Question: Generate an informative caption for the figure above.
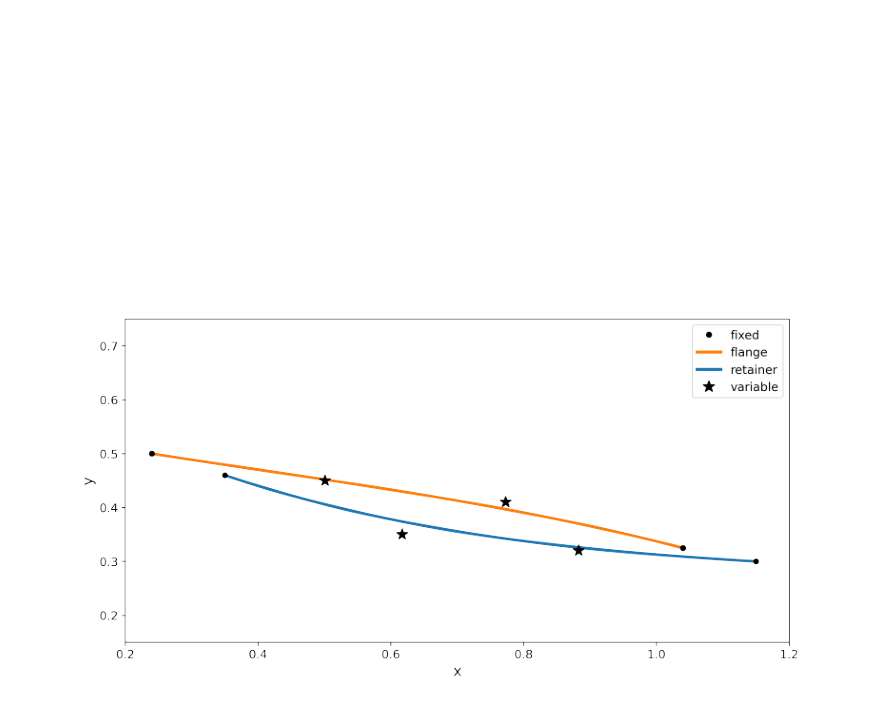
Answer: The curve to be optimized in the x −y plane. The y-coordinates of the ‘variable’ nodes are design variables.